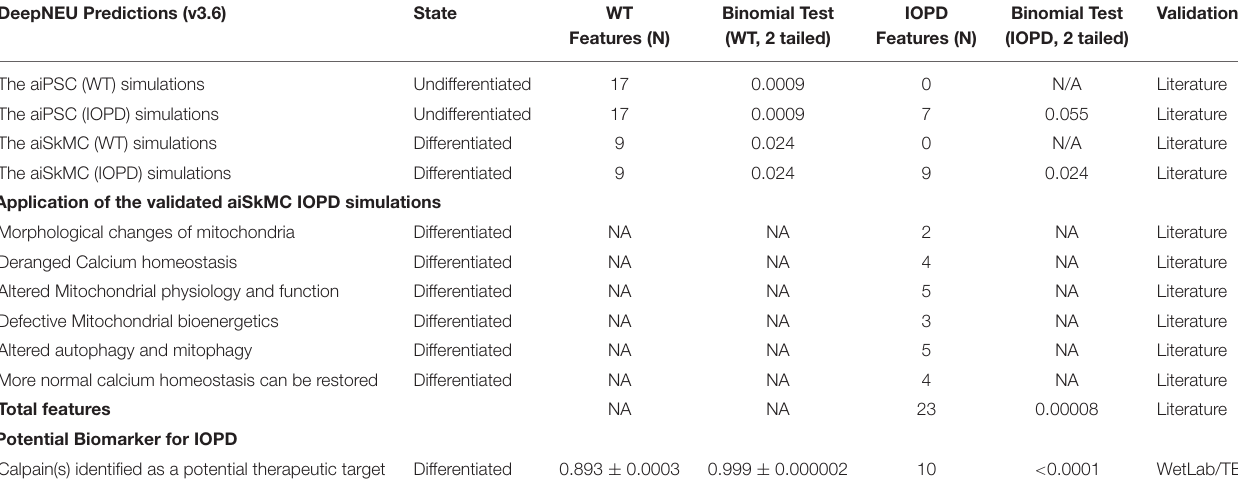
TABLE 2 | Summary of DeepNEU IOPD simulation main findings. DeepNEU Predictions